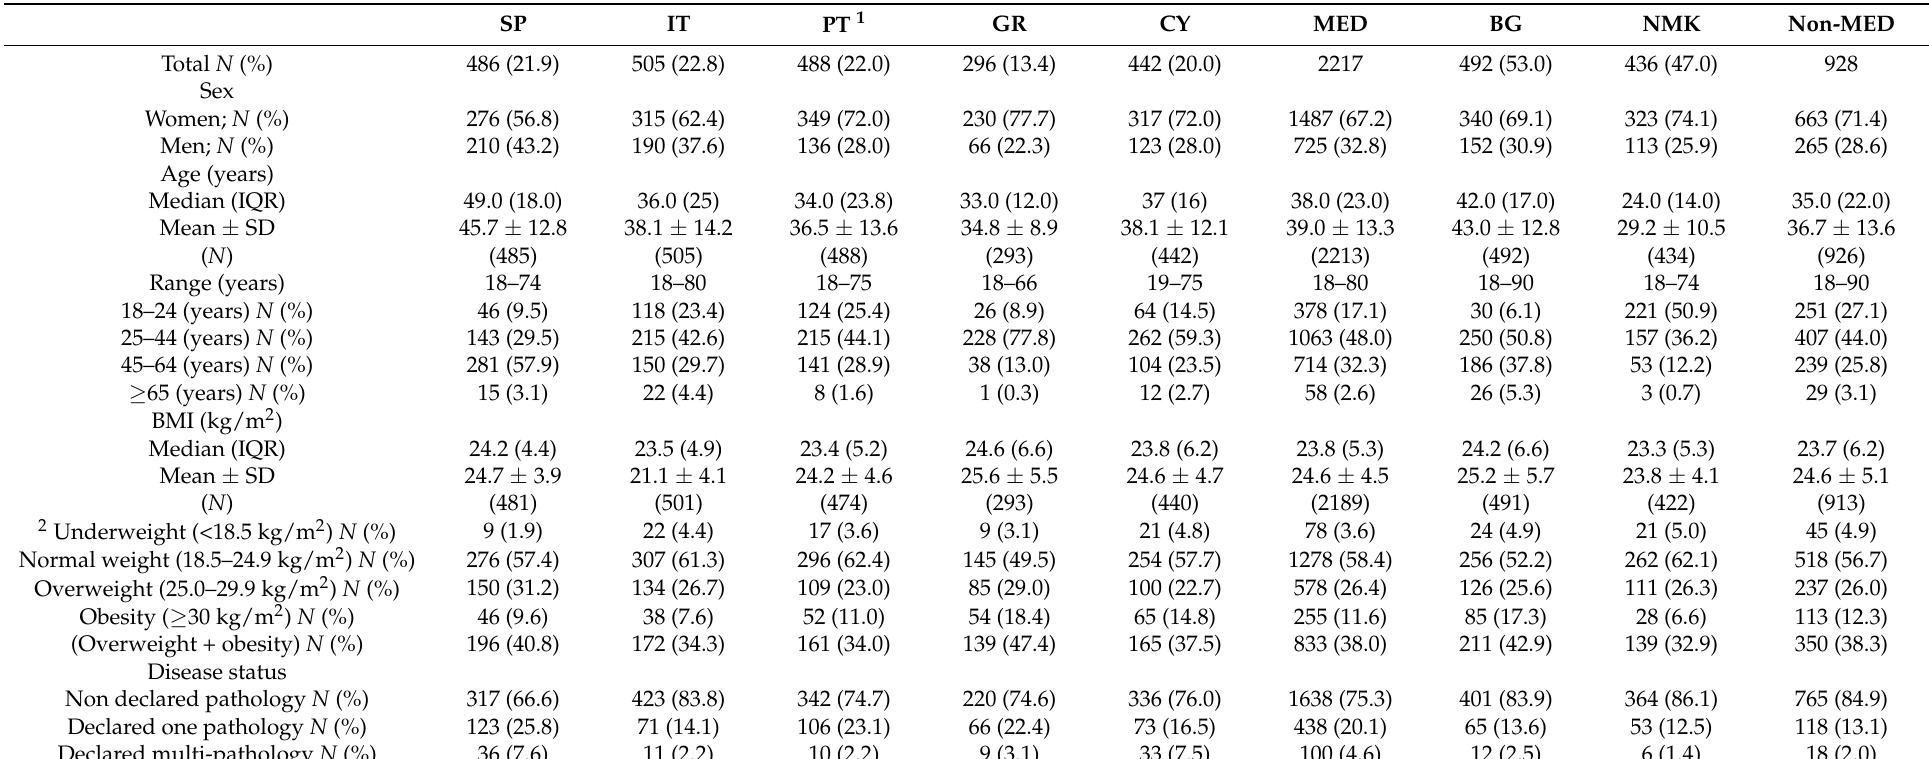
Table 1. Characteristics and distribution of the sample